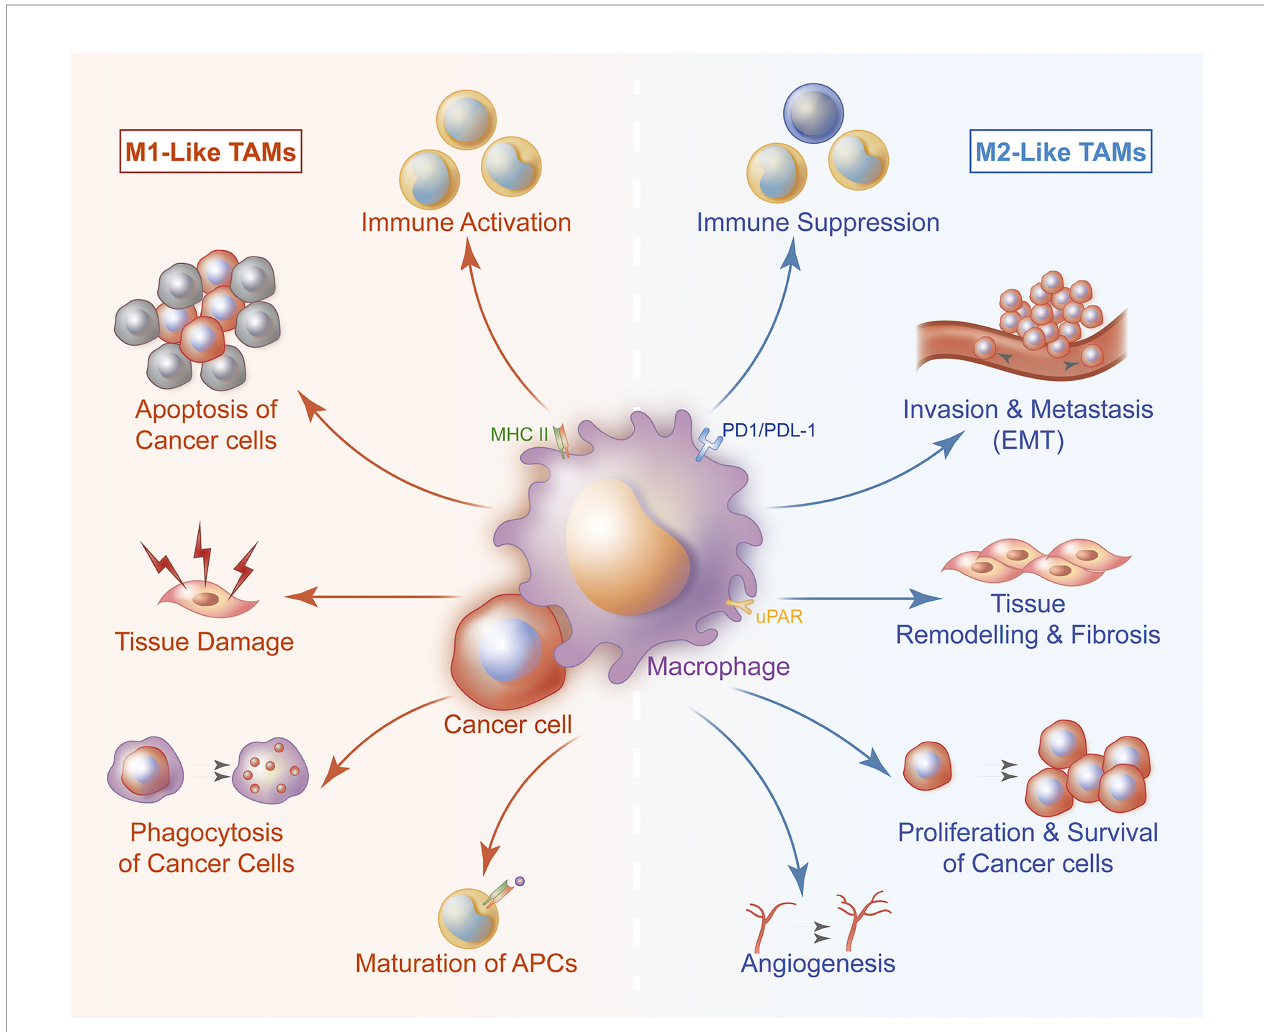
FIGURE 1 | TAMs are divided into typical activated M1 subtype and alternately activated M2 subtype. The two subtypes participate in the process of TNBC from occurrence to metastasis of TNBC. M1 exerts anti-tumor activity by promoting pro-in fl ammatory and immune responses. M1 can present antigen to immune cell, then these cells are activated and directed to kill tumor cells. M1 can also secrete cytokines to induce tumor cells apoptosis. M2 is involved in stimulating tumor angiogenesis, matrix remodeling, tumor cell migration and invasion, it also plays a signi fi cant role in immune suppression and tissue